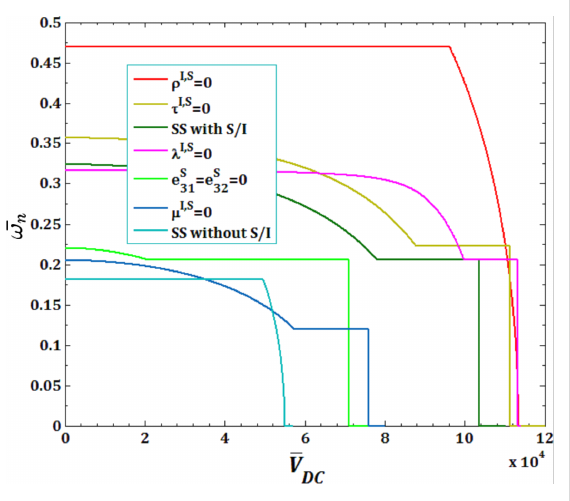
Figure 16: The effects of surface and interface parameters for pull-in voltage on DNF of SS FC-MWPENS.